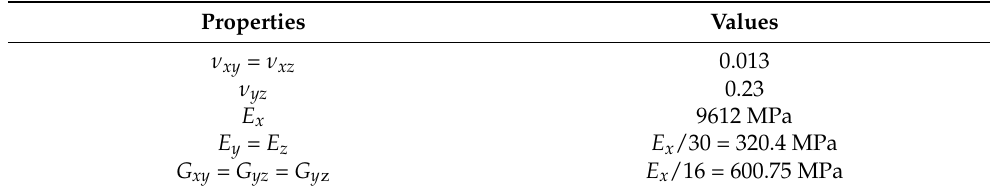
Table 5. Elastic properties and relations between admitted properties.